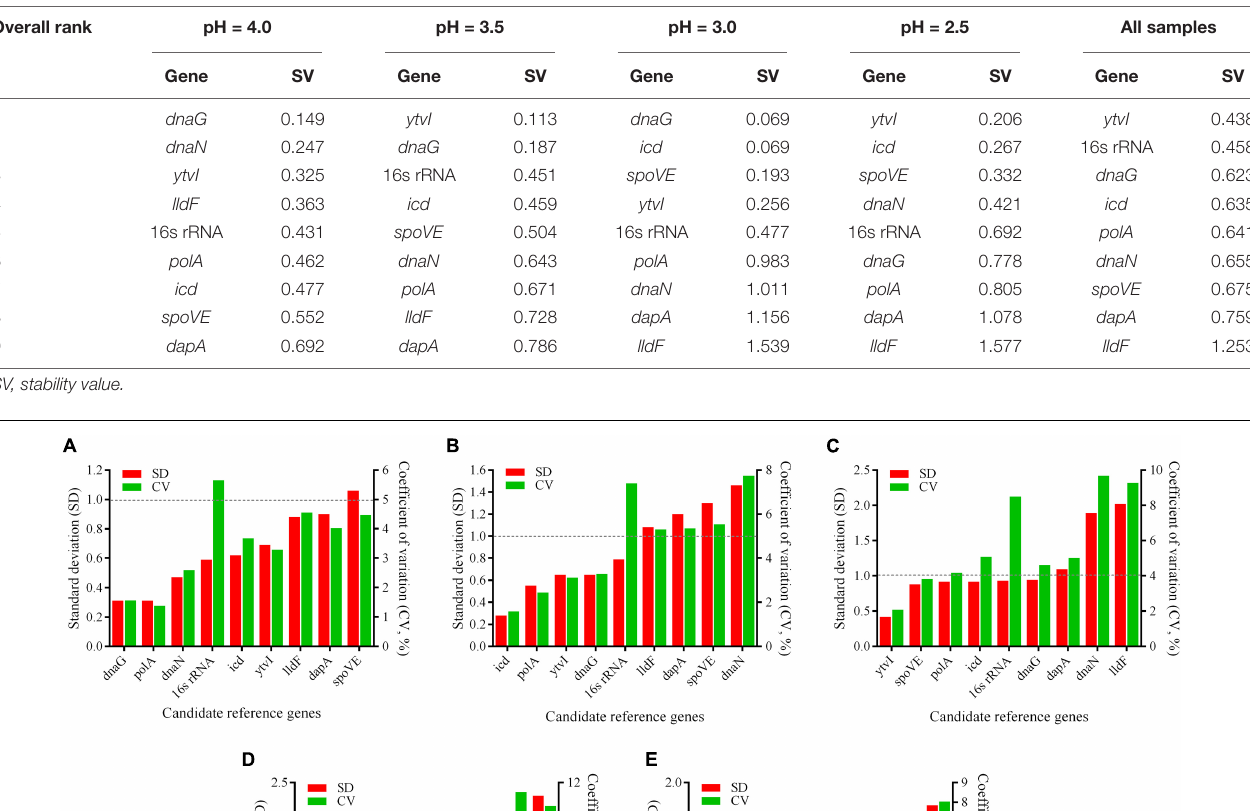
three acid-stressed cells. Meanwhile, spoVE was confirmed in